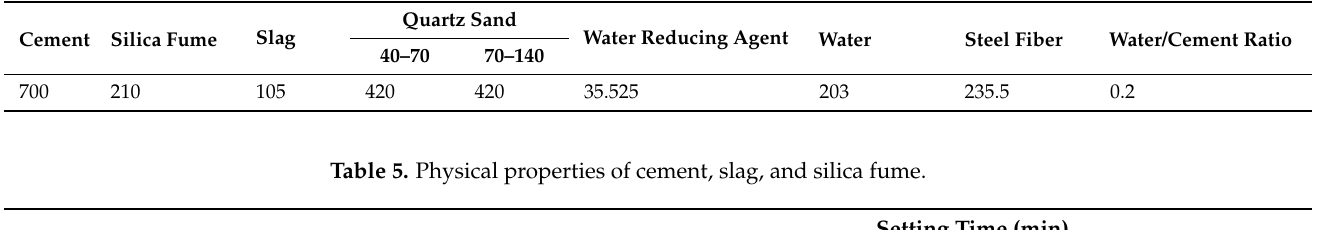
Figure 2. Steel fiber samples. Table 4. Ultra-high-performance concrete mix (kg/m 3 ).